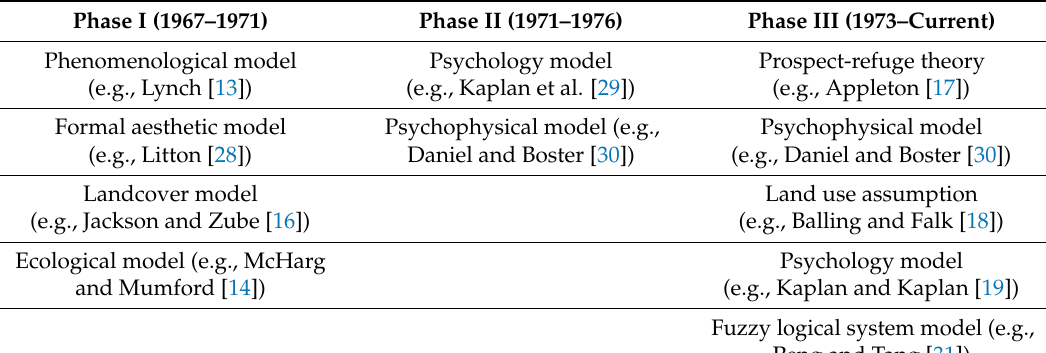
Table 2. Classification of the scenic beauty estimation method progressive time frame.